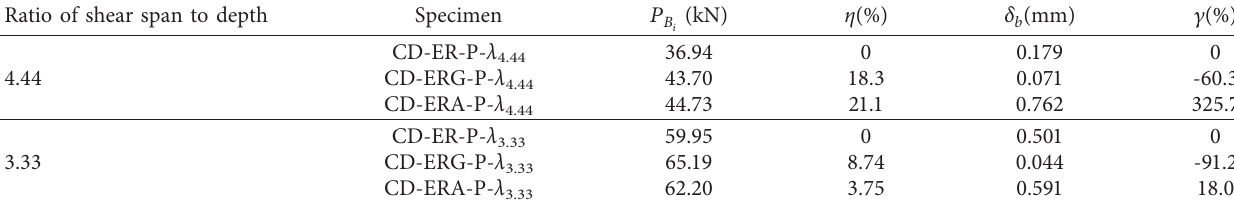
Table 5: Load-slip curve information of specimens.